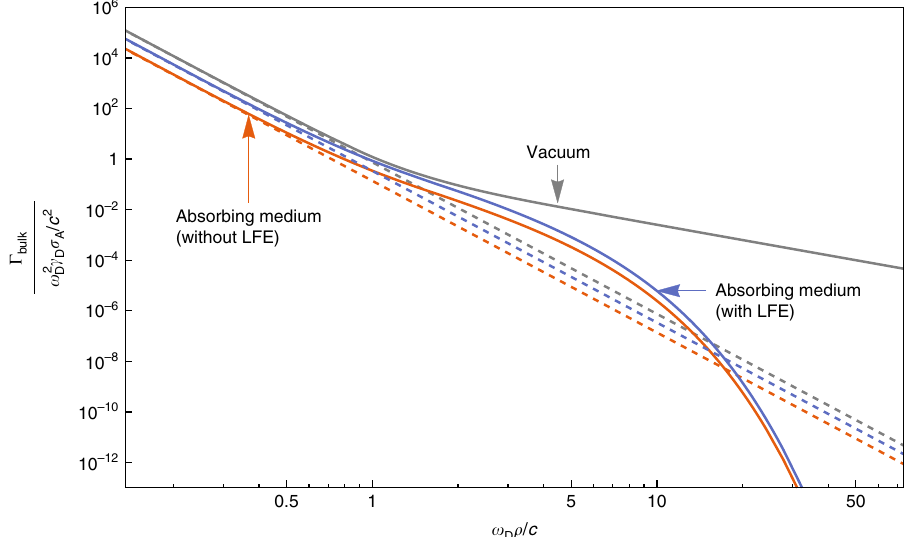
Fig. 5 Interplay of medium and retardation effects on interatomic Coulombic decay rate. Shown here is the interatomic Coulombic decay rate for arbitrary donor and acceptor, including medium and retardation effects as given by Eq. (10), as a function of the dimensionless parameter ω D ρ / c . The vertical axis is normalised in the same way as that of Fig. 2, and the dashed lines correspond to the non-retarded limits of the three rates shown. The material parameters chosen for the absorbing medium are n ( ω D ) = 1.49 and κ ( ω D ) = 0.35, corresponding to the fi rst absorption line of helium 41